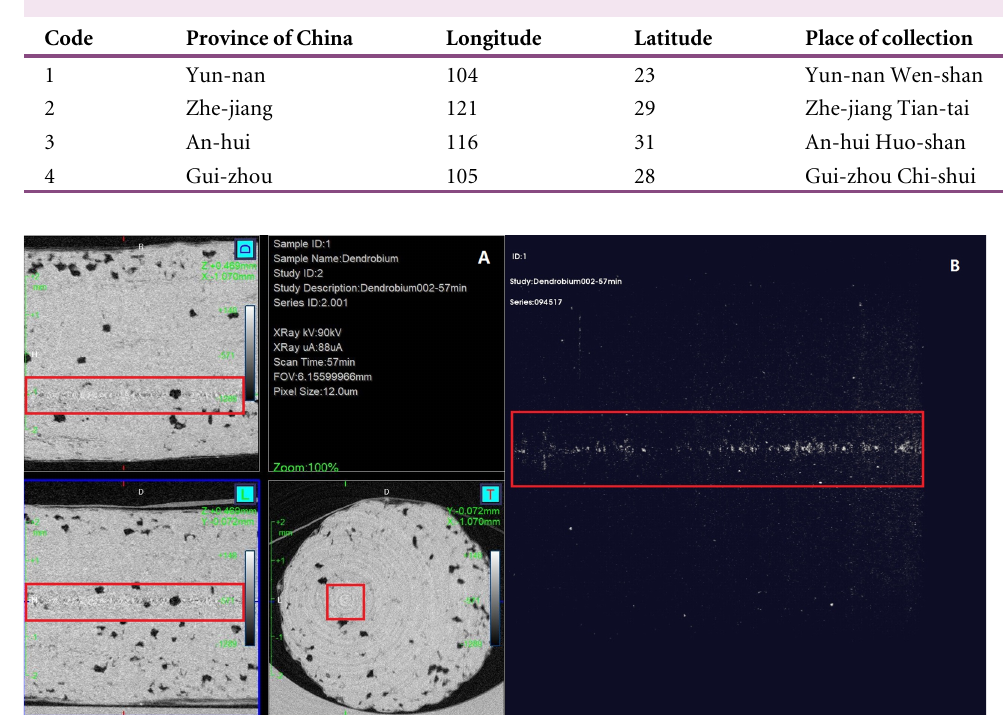
Table 1 The origin information of Dendrobium samples.